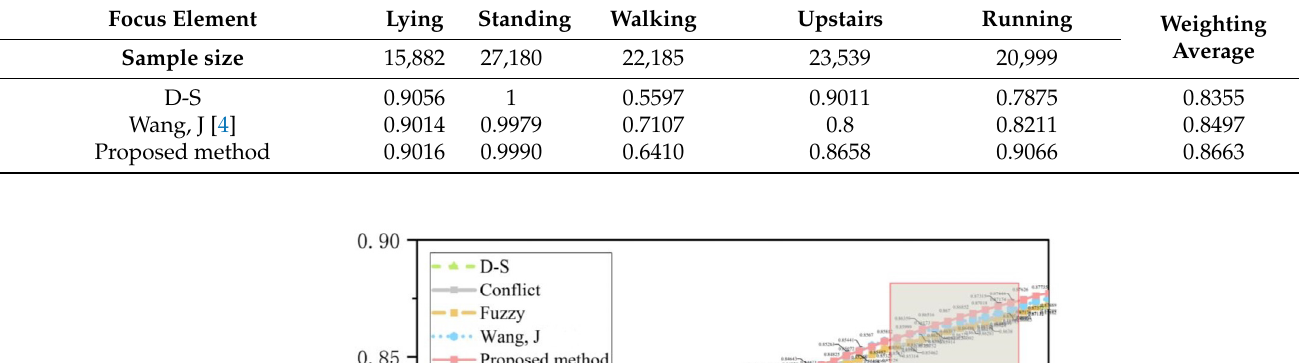
Table 6. Accuracy of different methods.